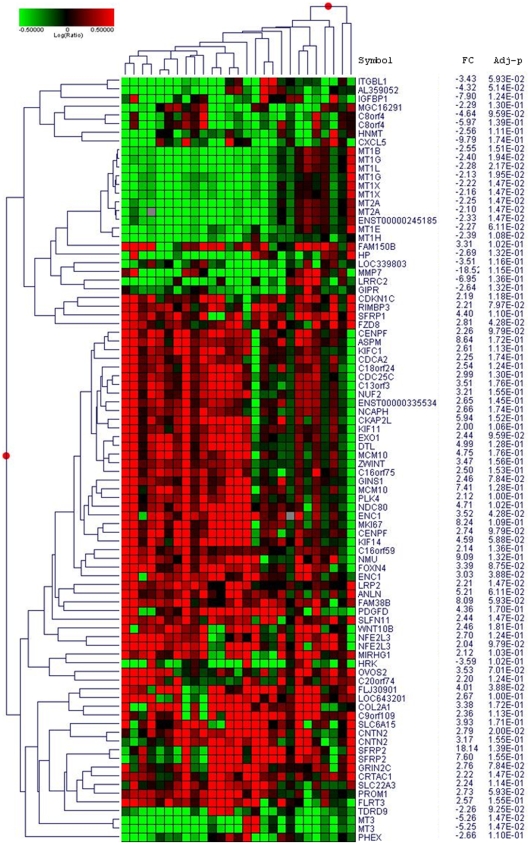
Supervised hierarchical clustering of differentially expressed genes in ependymoma relapse compared to diagnosis.Heatmap showing the 87 genes signature of the genes statistically up- or down-regulated in more than 50% of relapses with a fold change >2. Notice the homogeneity of the underexpression of the metallothioneins.